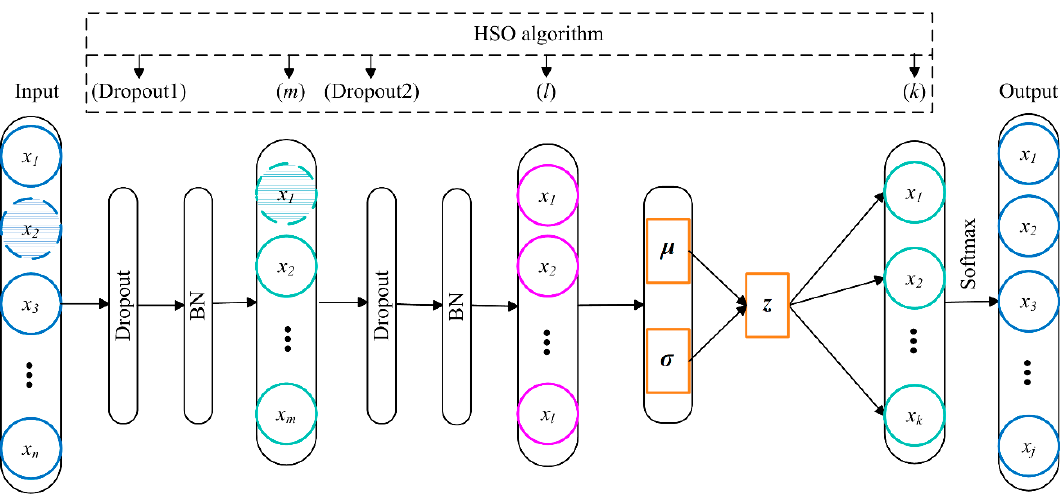
Figure 5. The proposed variational stacked autoencoder with harmony search optimizer (HSO– VSAE)